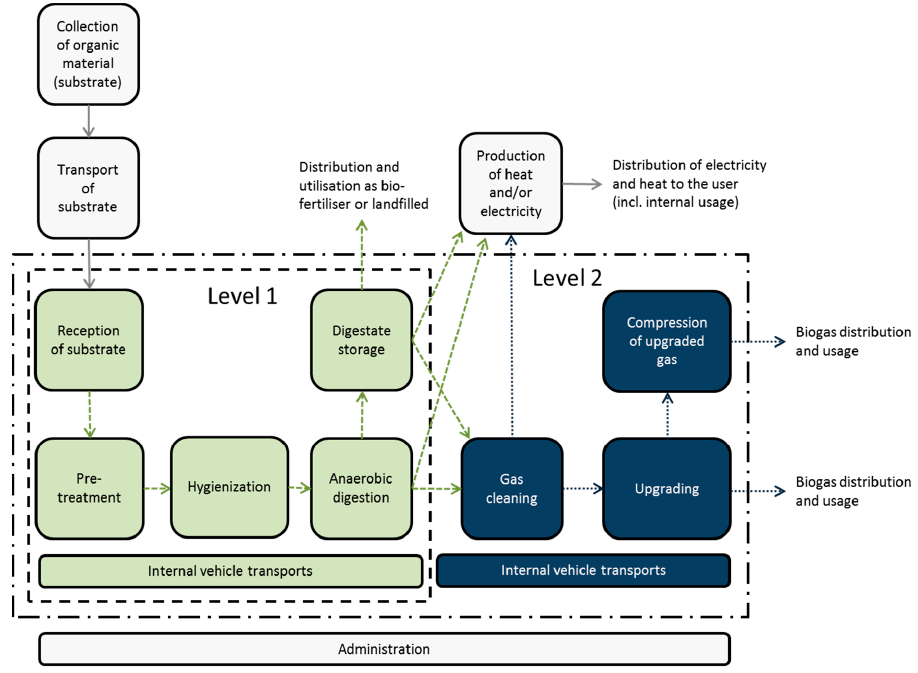
Figure 2. The biogas system with the sub-processes. The sub-processes in green are included in the first system level: Level 1, the inner system boundary. The sub-processes in green and blue are included in the larger system level: Level 2, the outer system boundary. The sub-processes outside the system boundaries, in grey, are excluded from the systems studied.